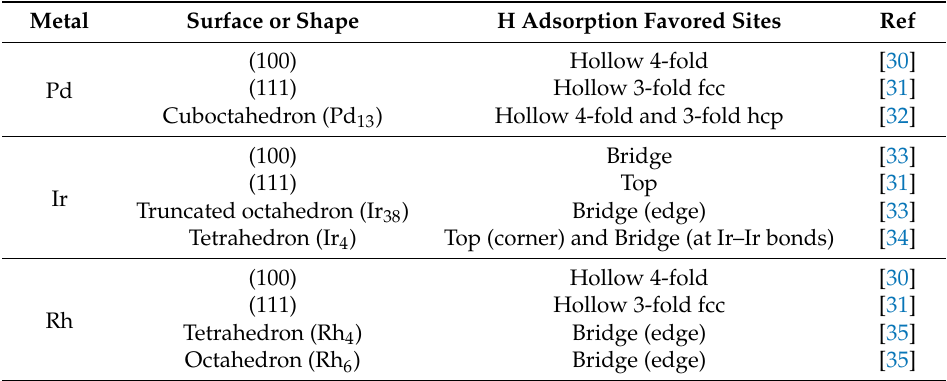
Table 2. Most favored hydrogen adsorption sites for Pd, Ir, and Rh flat surfaces and clusters determined from DFT/ab initio